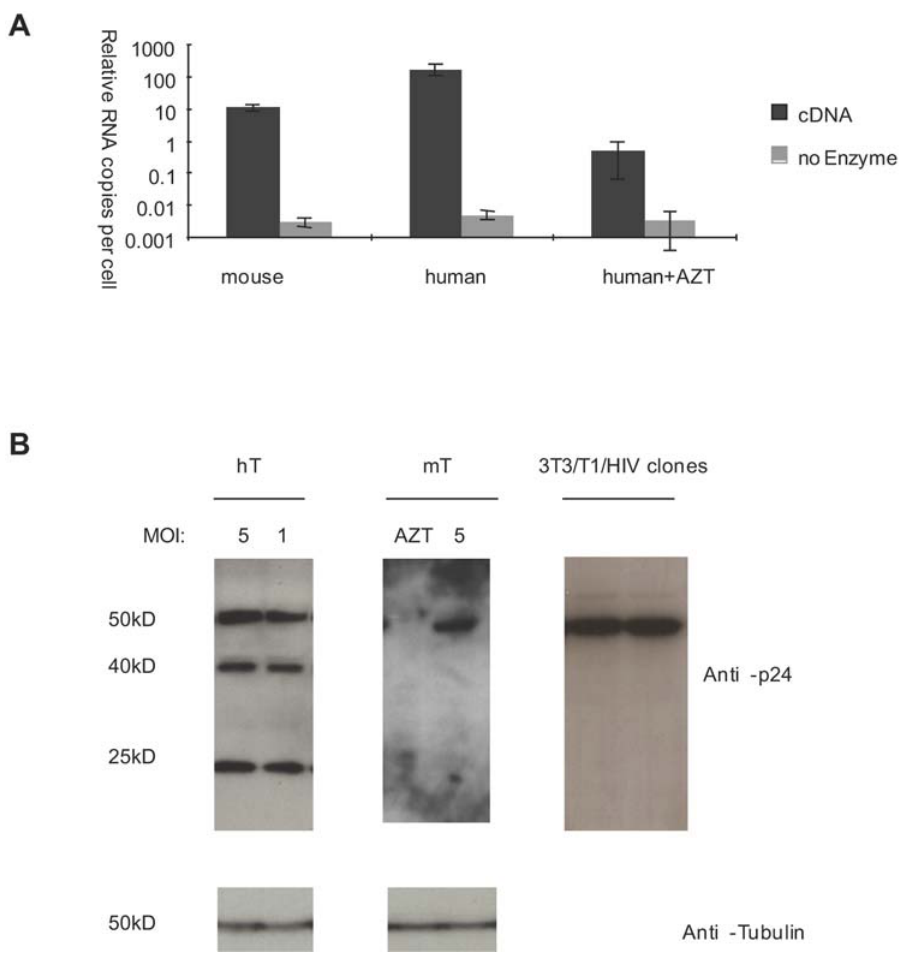
Figure 7. Analysis of HIV-1 RNA and proteins in infected primary mouse T cells. Primary CD4 + T cells from hCyclin T1 mice (mT) or human PBMCs (hT) were infected with VSVG-pseudotyped HIV-GFP at MOI of 2 in the presence or absence of AZT. Forty-eight hours later, cells were collected. (A) Total RNA was extracted from infected cells. Infection in the presence of AZT served as negative control for de novo expression of RNA. cDNA formation in the absence of reverse transcription enzyme served as negative control for contaminating DNA. Real Time-PCR was performed using primers and probes specific for 18S rRNA and R-U5 (HIV). The ratio of HIV to 18S rRNA was further normalized by infection efficiency to show the relative copy numbers of HIV RNAs per infected cell. hCyclinT1 mice gave an average of 20% infection efficiency, while human T cells gave an average of 50%. (B) Total cellular proteins were analyzed on 12% acrylamide gels and subjected to western blot analysis with anti-p24 monoclonal antibody. Endogenous a -tubulin was analyzed on the same membrane as a loading control. As a comparison, stable clones derived from 3T3/Cyclin T1 infected with HIV-GFP (VSVG) were analyzed in parallel.